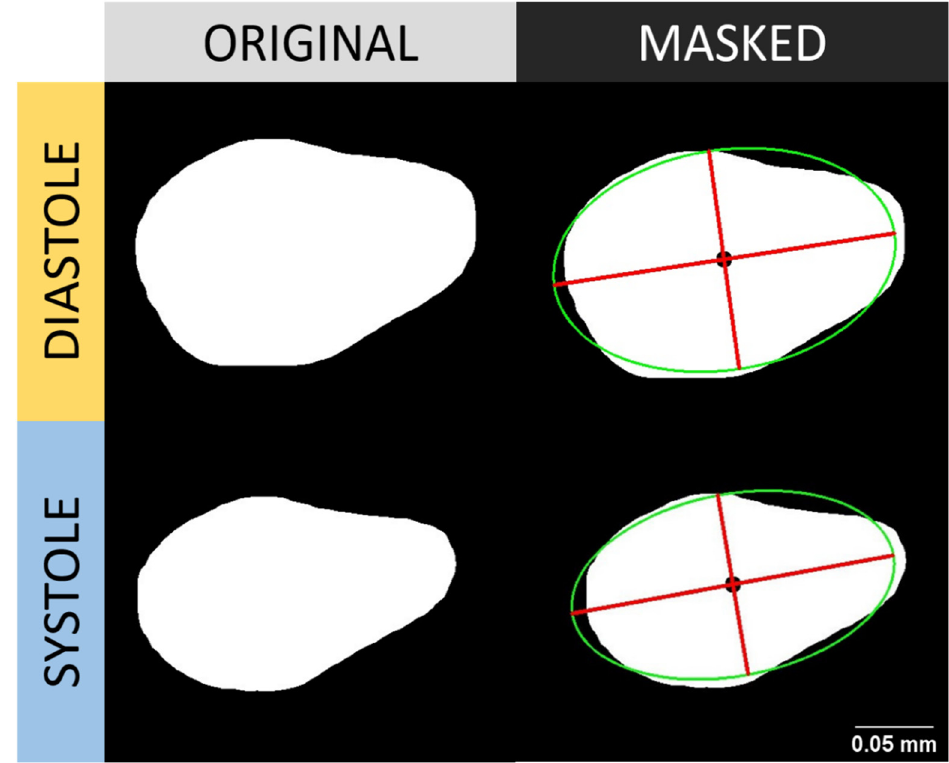
Figure A2. Detection of the short (minor) and long (major) axes of the heart chamber using fit ellipse function in OpenCV. The heart images at either diastolic or systolic phases were used for long and short axis length extraction. The binary images before (left panel) and after (right panel) performing the Cv2.fitEllipse function in OpenCV were listed for side-by-side comparison. Scale bar was provided for size